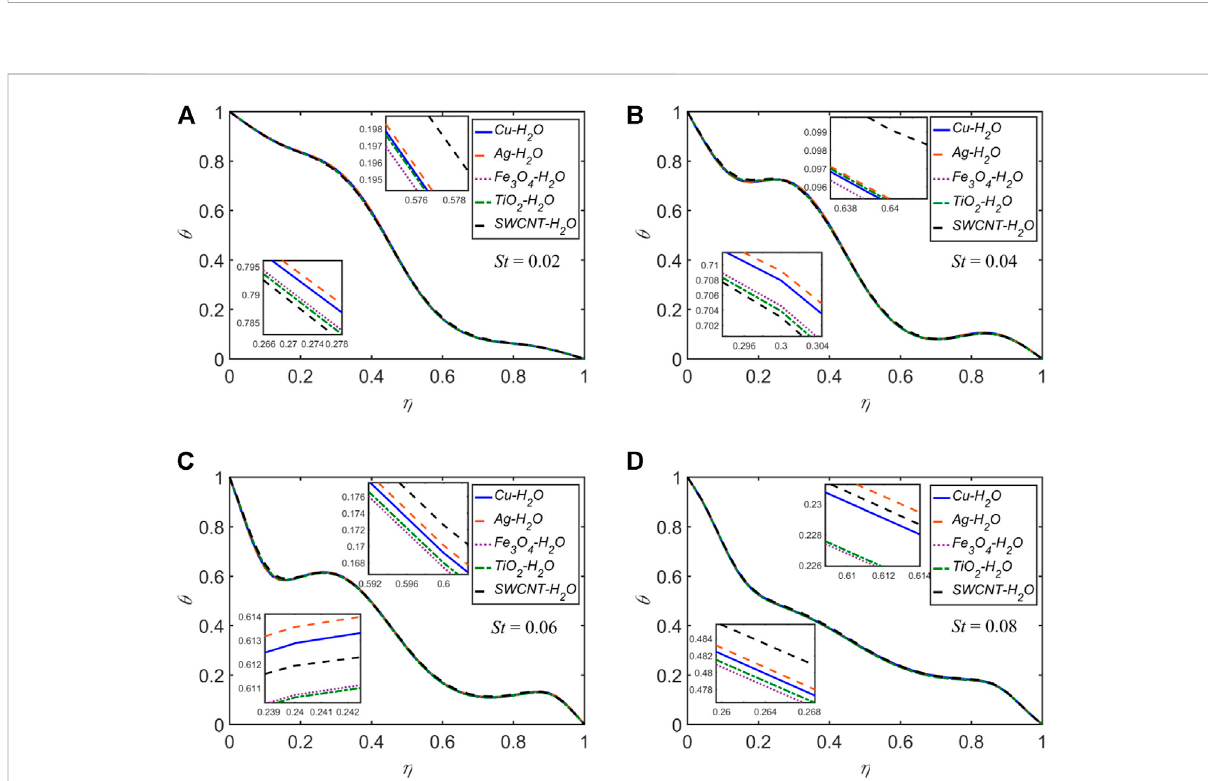
The temperature pro fi le θ versus η at x (cid:2) 2 and t (cid:2) 0 . 25 for the fi ve NFs for distinct values of St